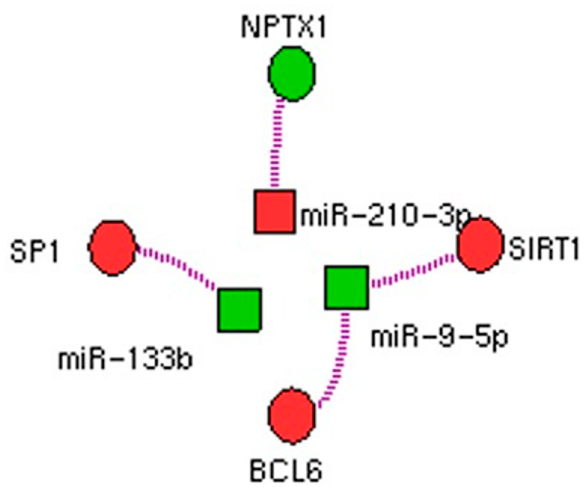
Figure 3. Networks between miRNAs and genes: deregulated miRNAs and deregulated genes in PDGFRA D842V GISTs vs. non-D842V GISTs. Green color represents up-regulation and red color represents down-regulation.